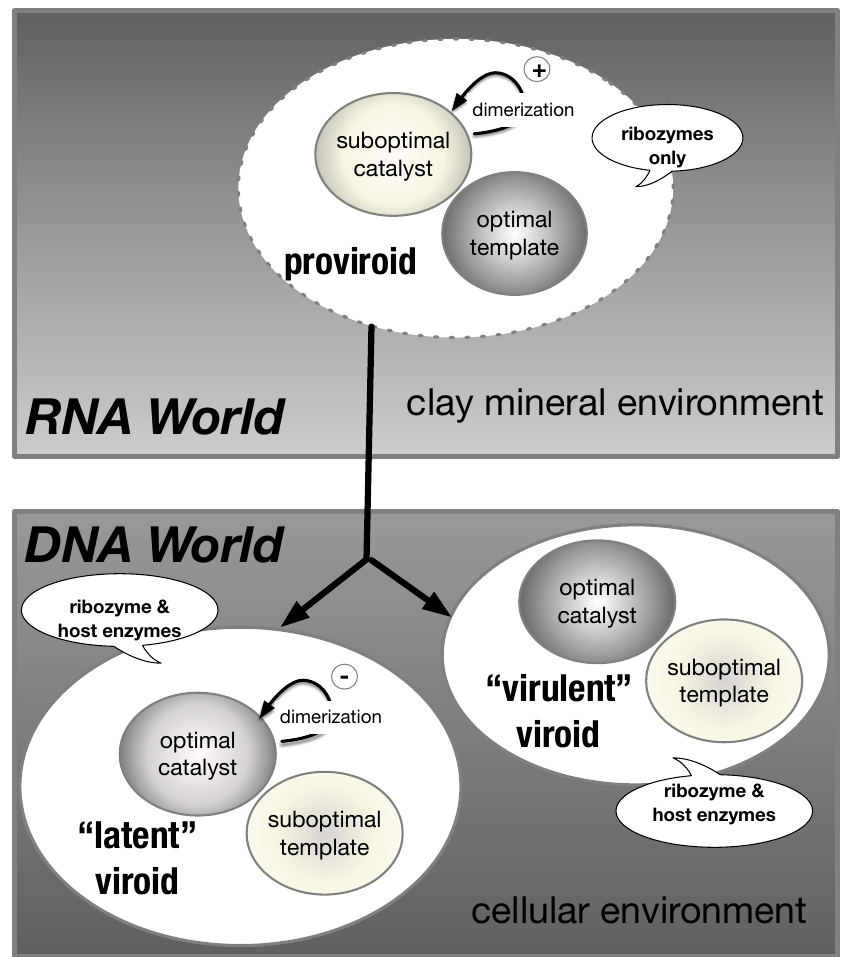
Figure 7. A model for the evolutionary path of the transition from proviroids (RNA World) to viroids (DNA World). In a clay mineral environment (RNA World), the proviroids are suboptimal catalysts that retain an optimal template activity. The catalytic activity can be increased by “bonded” dimerization (double-hammerhead structures). In a host (DNA World), “virulent” viroids are efficient as catalysts and suboptimal templates, while “latent” viroids (ASBVd) have a regulatory control of their catalytic activity by “non-bonded” dimerization (non-bonded dimeric structures). The bubbles indicate the enzymes required for the replication